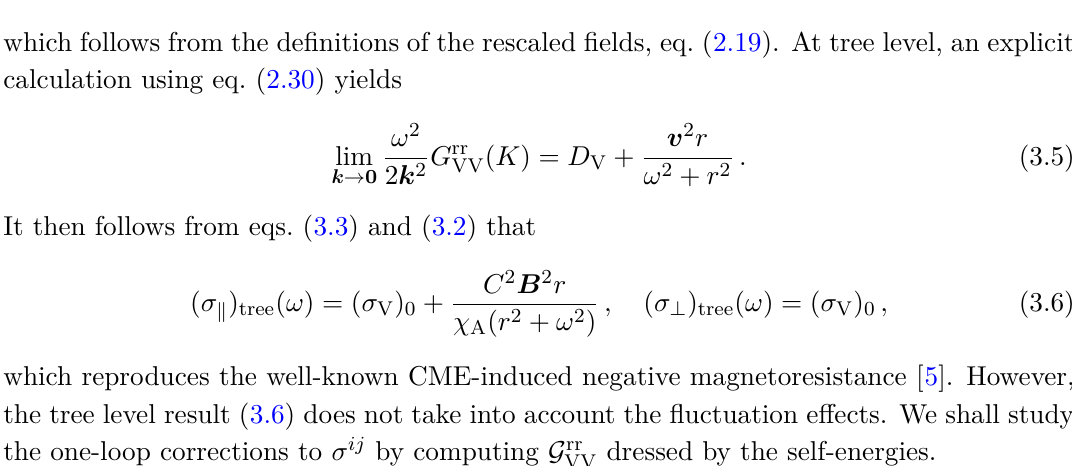
Figure 2 . Diagrammatic representations of the Dyson equations: (a) for the G ra propagator (3.8); (b) for the G rr propagator (3.9). The last expression on (b) is the first-order expansion with respect to the self-energies. Here, double lines represent the full propagators. The white bubbles and the bubble with diagonal lines correspond to Σ aa and Σ ar , respectively. The cross vertex denotes − N , which is related to the free propagators by eq. (2.30). Note that ( α, β ) labels are suppressed in these